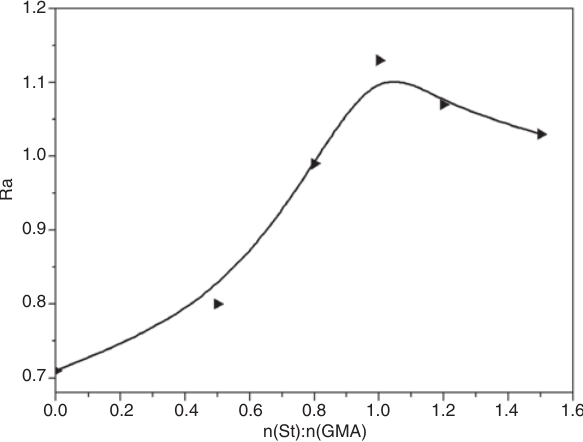
Figure 10 Effect of St concentration on GD